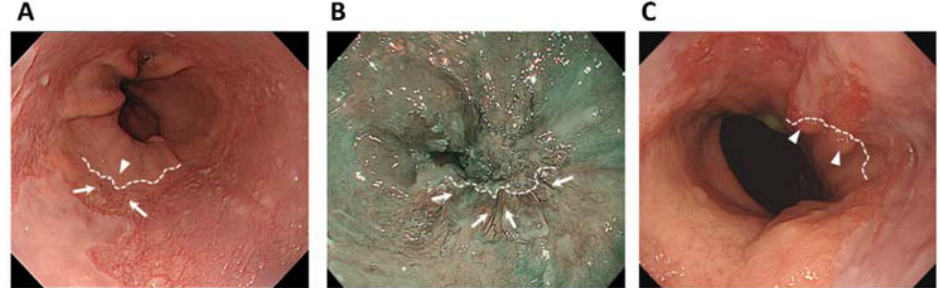
Figure 1. Endoscopic images from which the esophagogastric junction (EGJ) line was estimated. ( A ) A representative white light image of a non-cancer patient with Barrett’s esophagus. The EGJ line was estimated (broken line) where the lower end of the palisade vessels (arrows) and the upper end of the gastric folds (arrowheads) are almost coincident. ( B ) A narrow-band image of an EGJ cancer patient. The EGJ line was estimated from the lower end of the palisade vessels (arrows). ( C ) A white light image of an EGJ cancer patient. The EGJ line was estimated from the upper end of the gastric folds because the palisade vessels could not be visualized.